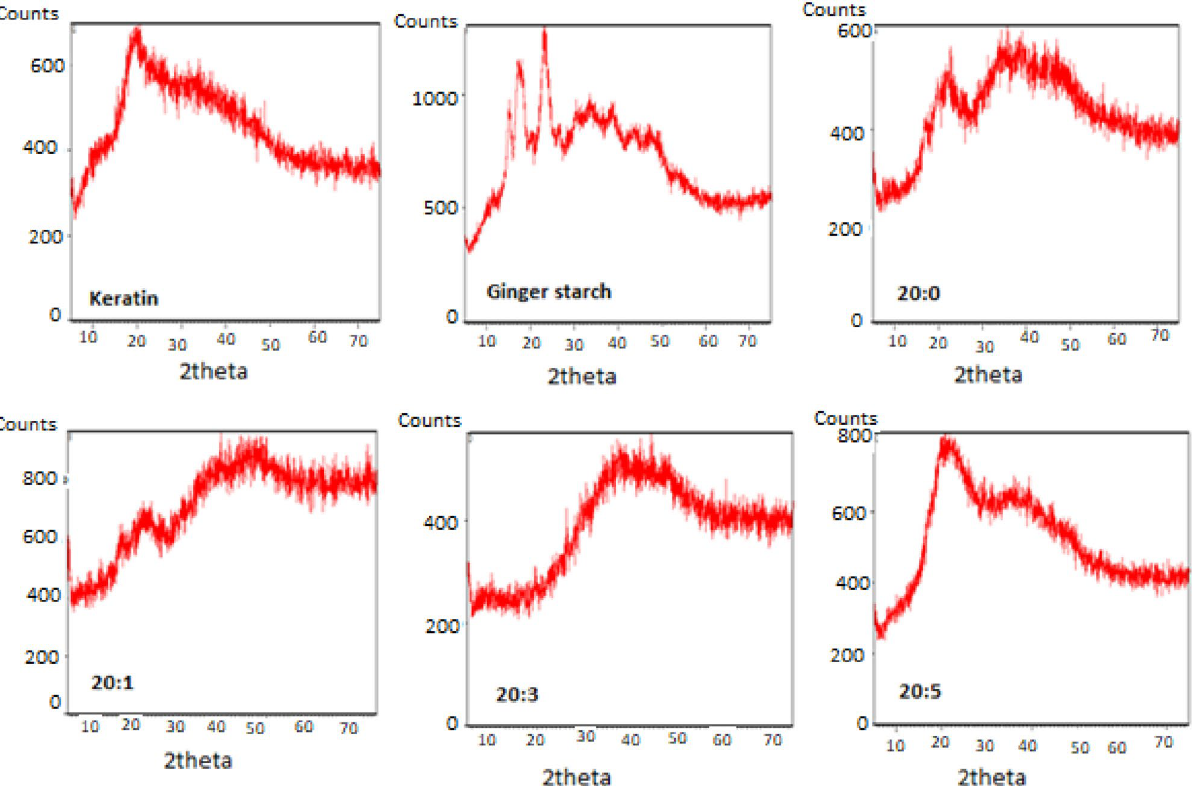
Figure 7. XRD spectra of keratin, ginger starch, and biocomposite films made of difference blends of starch and keratin solutions. Note: 20:0, 20:1, 20:3, and 20:5 = starch/keratin ( v / v